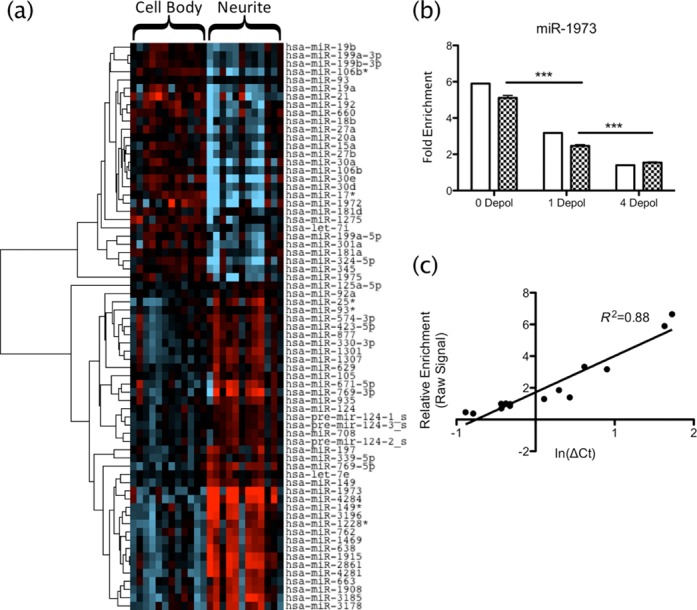
miRNA compartmentalization in neurites. (a) T-test was used to find miRNA differentially expressed between compartments (P < 0.05), independent of depolarization. Heat map shows supervised clustering of miRNA expression in neurites versus cell bodies. Two main clusters are revealed, indicating miRNA with low (blue) and high (red) expressions in neurites compared with cell bodies. (b) qRT-PCR results (chequered bars) closely matched those seen by microarray (open bars), both in enrichment and response to depolarization; miR-1973 shown is representative of 5 miRNA validated across 3 depolarization statuses (15 samples total). (c) Correlation of microarray and qPCR expression had R2 = 0.88, validating the microarrays.